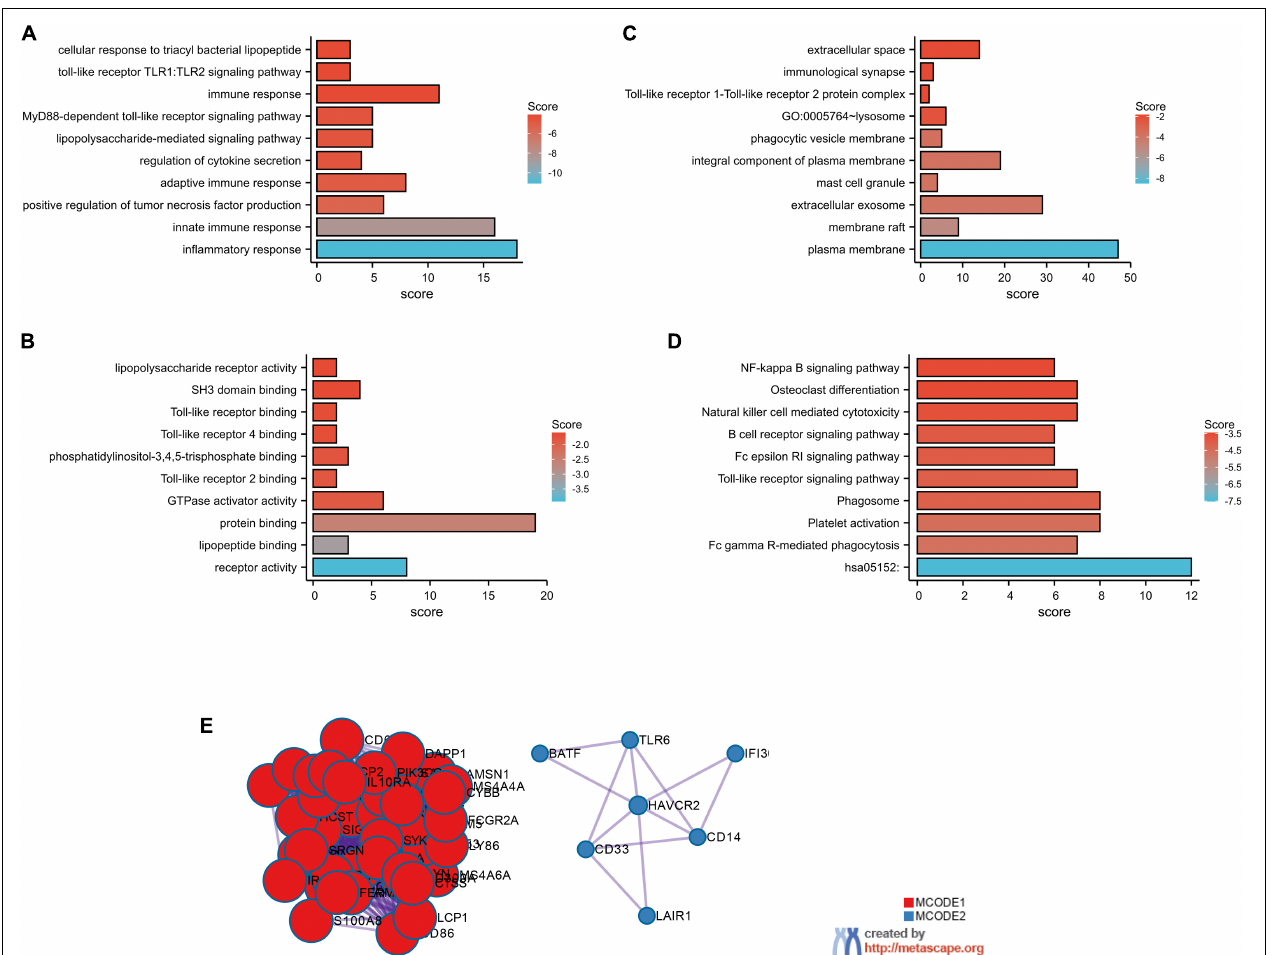
FIGURE 4 | GO functional enrichment of GMFG-related terms in gliomas. The top 100 genes that were positively correlated with GMFG (Spearman r > 0.50, P < 0.01) were downloaded from the cBioPortal platform (http://www.cbioportal.org/) based on TCGA-GBM. GO enrichment analysis were classified into three. (A) Biological process; (B) molecular function; (C) cellular component categories. (D) KEGG pathways prediction. (E) Protein–protein interaction networks were performed in Metascape (http://metascape.org/).